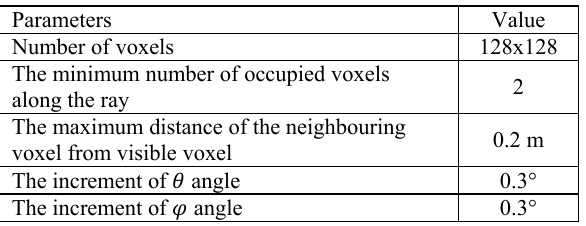
Table 1 . Parameters of the gap detection algorithm.